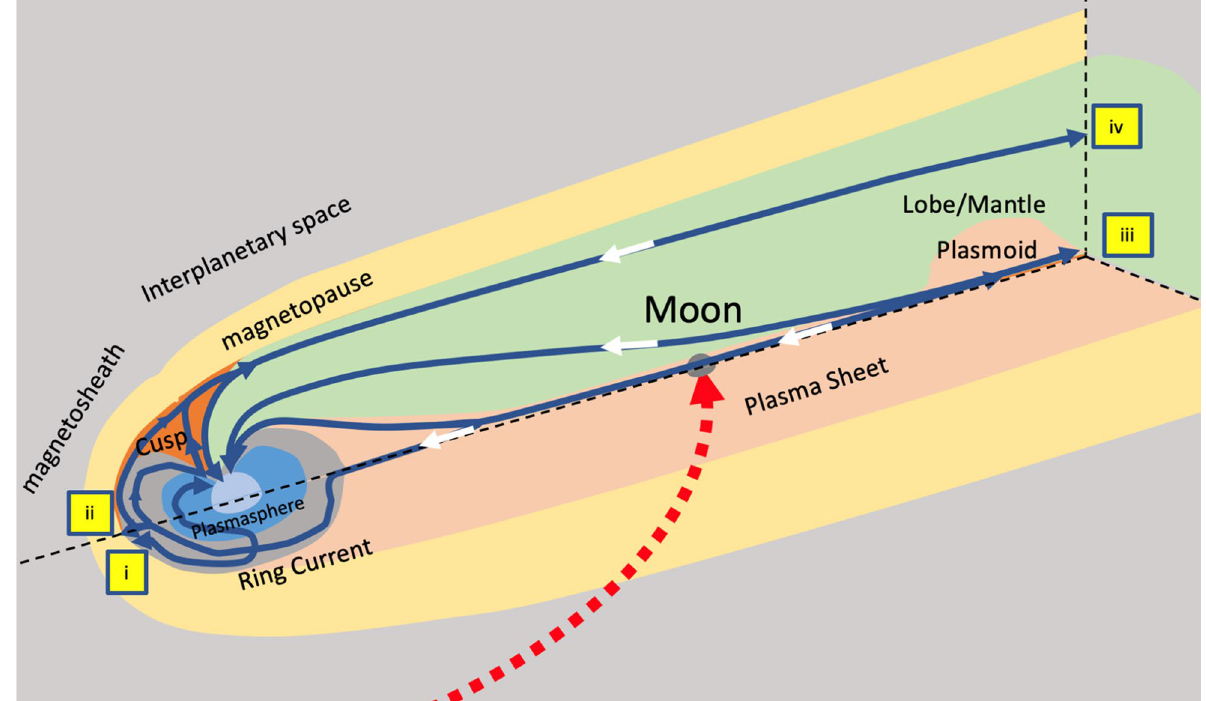
Figure 1. Sketch showing three-dimensional cutaway of Earth’s magnetosphere. The blue and white arrows are motion pathways of ions (for details see Seki et al. 5 ) illustrating the mechanism for oxygen/hydrogen ions transfer to the Moon. Red dotted line with the arrow shows motion of the Moon into the magnetospheric tail. Escape locations into the interplanetary space is marked by locations i, ii, iii, iv. Image was drown using Microsoft PowerPoint for Mac Version